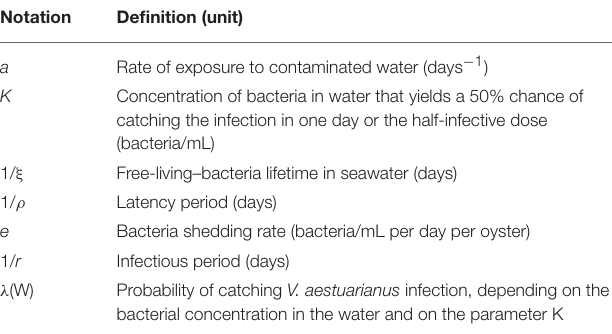
TABLE 1 | Definition of model